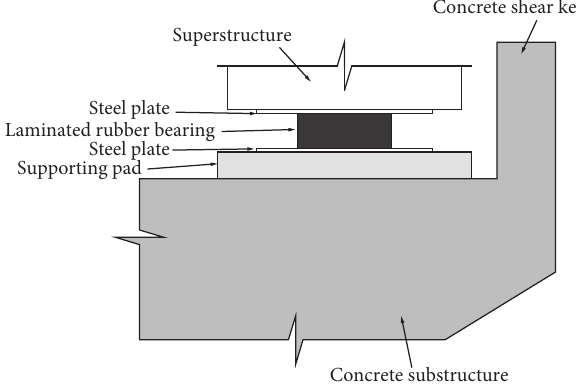
Figure 1: Layout of laminated-rubber